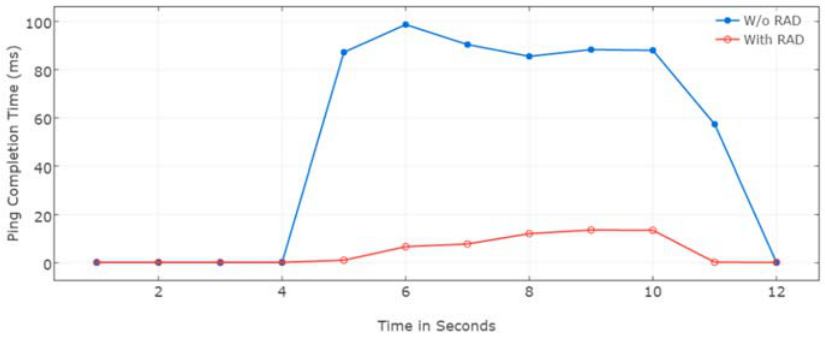
Figure 12. Ping completion time (Effect of mice flows).